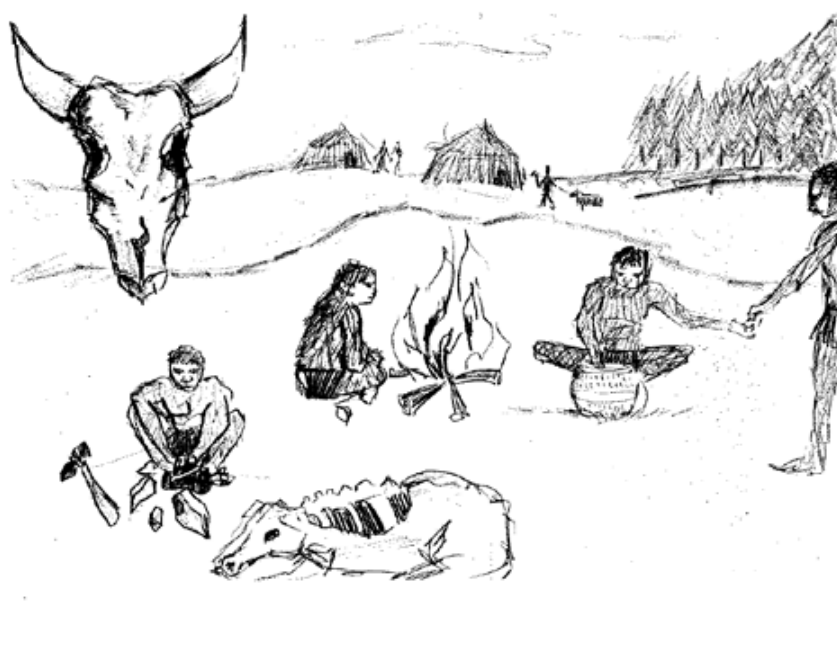
Fig 5. Visitor’s ’map’ of ’London before